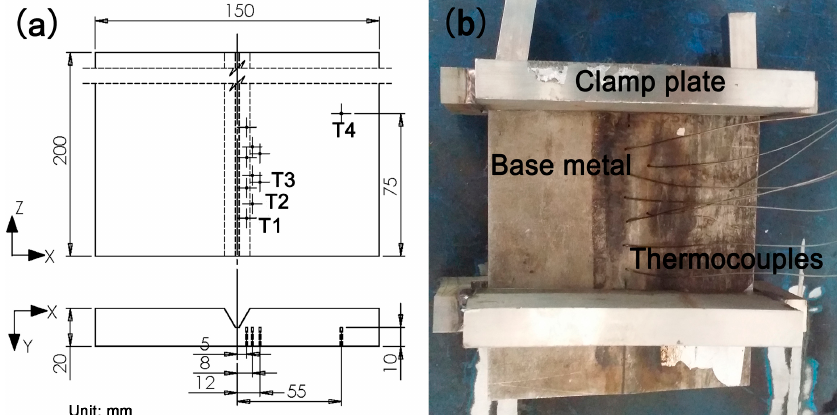
Figure 3. Arrangement of the K-type thermocouple with a thermocouple wire diameter of 0.1 mm: ( a ) dimension of welding plate and location of thermocouples; and ( b ) thermocouples attached to the welding plate.